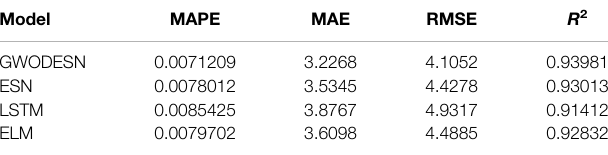
TABLE 4 | Prediction performance comparison for